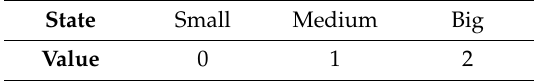
Table 1. Language conversion of ultrasonic distance range